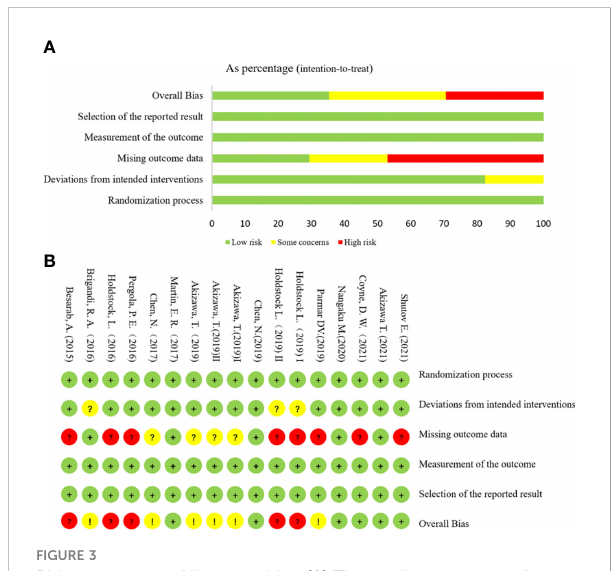
FIGURE 3 Risk assessment of literature bias. (A) The quality assessment for each bias risk item is presented as a percentage. (B) Quality assessment of each bias risk item for each study. Each color represents a difference in the risk of bias: green represents low risk of bias, yellow represents unclear risk, and red represents high risk of bias.